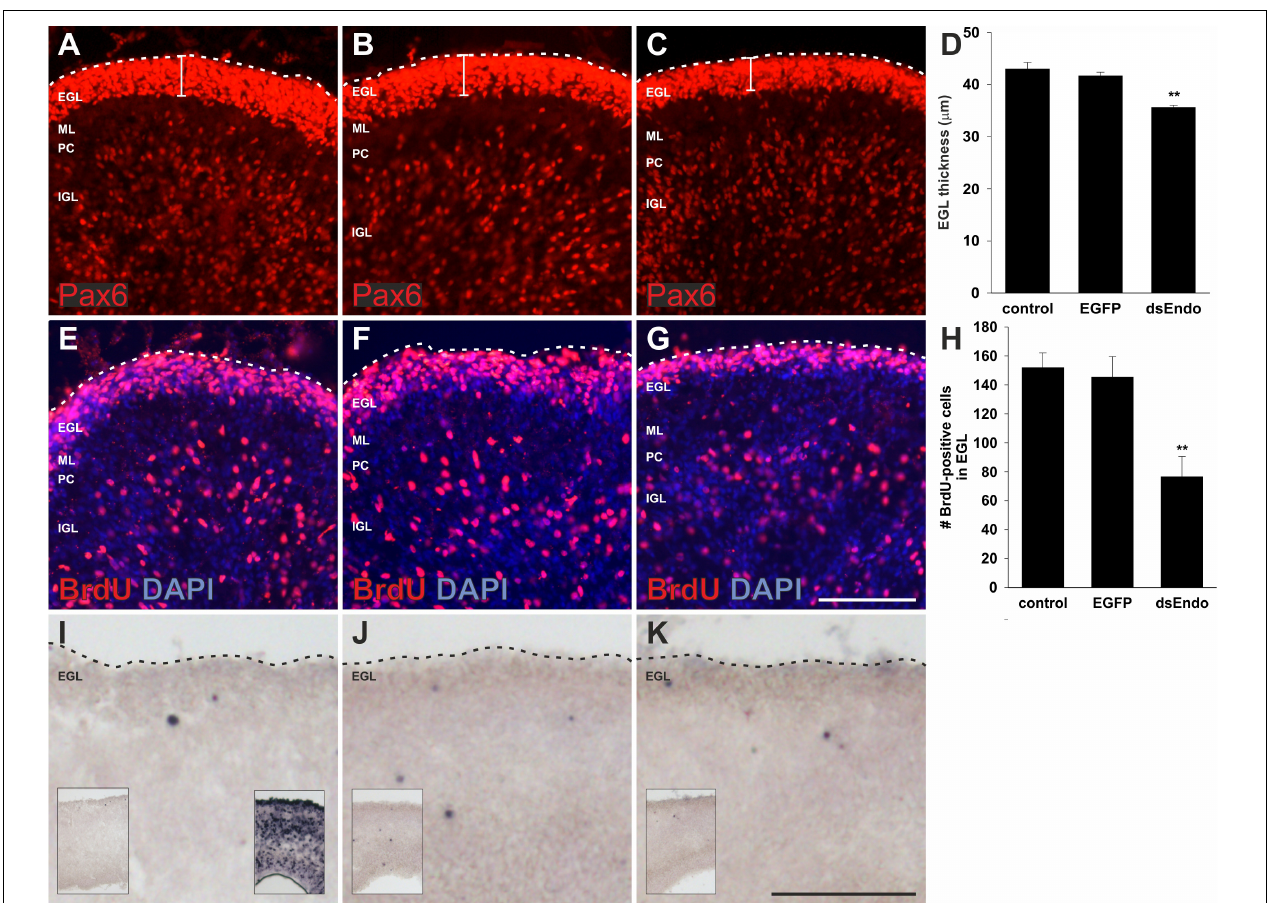
FIGURE 4 | The external germinal layer is reduced due to a reduction in granule cell proliferation after silencing Endoglycan. The width of the external germinal layer (EGL) was measured in sections taken from embryos sacrificed at HH35, 1 day after ex ovo electroporation (A–D) . Pax6 stains proliferating granule cells in the EGL of untreated control embryos (A) , control-treated, EGFP-expressing embryos (B) , and in embryos injected and electroporated with dsEndoglycan (dsEndo; C ). The thickness of the EGL was significantly reduced in embryos lacking Endoglycan (D) . Thickness of the EGL was determined as 43 µ m in non-treated and 41.7 µ m in control-treated brains, compared to only 35.6 µ m width in the dsEndo group (** p = 0.0023 for dsEndo vs. non-treated, and ** p = 0.0096 for dsEndo vs. EGFP-expressing controls). The decrease in granule cell proliferation was confirmed by staining for BrdU. The number of BrdU-positive cells was significantly lower in dsEndo-treated embryos ( G,H ; 76.6), compared to untreated ( E ; 152) and control-treated embryos ( F ; 145.5). ** p = 0.0021 dsEndo vs. untreated, ** p = 0.0085 dsEndo vs. EGFP-expressing controls. We also compared apoptosis in the cerebellum of untreated (I) , control-treated (J) , and dsEndo-treated (K) embryos. We found no contribution of cell death to the number of granule cells, as we did not see apoptosis at this stage of development. The inserts in (I–K) show lower magnification overviews. The insert in the right corner of (I) shows a positive control, where DNA fragmentation was induced with DNase treatment. One-way ANOVA with Tukey’s multiple comparisons test used for statistical analysis. EGL, external germinal layer; ML, molecular layer; PC, Purkinje cell layer; IGL, inner granule cell layer. Bar, 100 µ